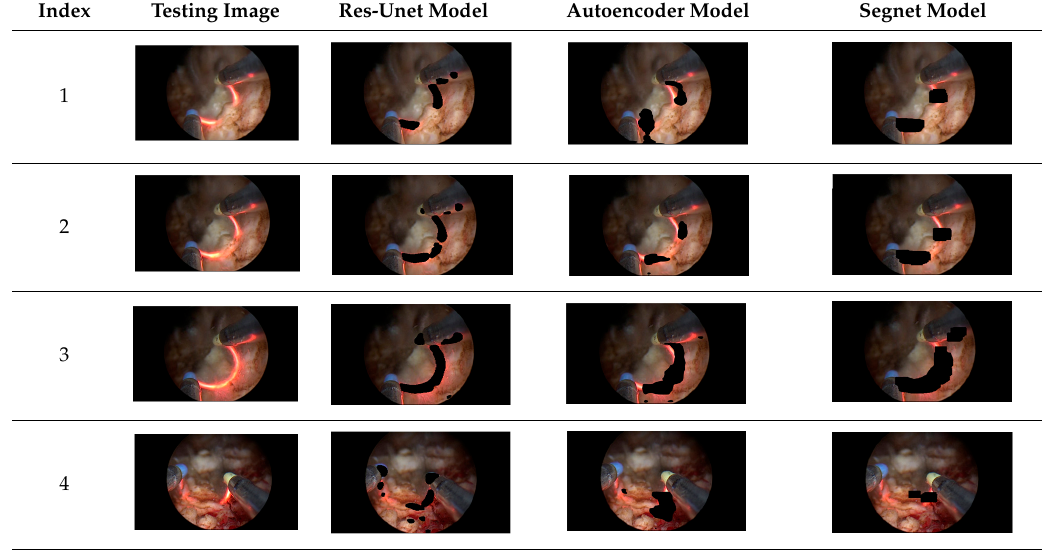
Table 11. The comparison of removing the misjudgment area.